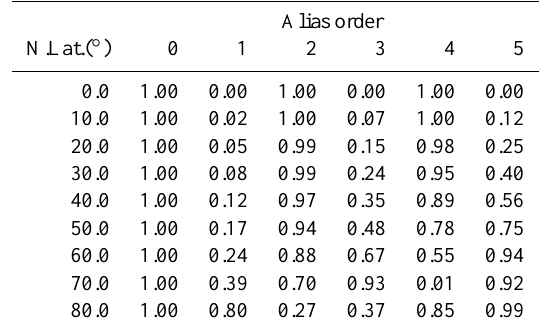
Amplitudes of aliases for orbit tilt = 8 ◦ , t s =1d, t orb = 91.6791min versus